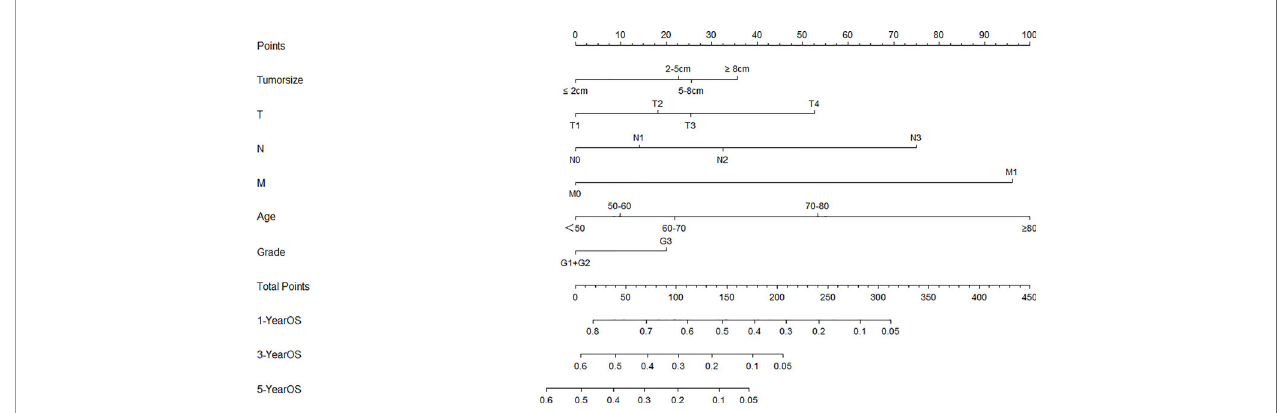
FIGURE 1 | Nomogram for overall survival developed from the training cohort. T, clinical T status; N, clinical N status; M, clinical M